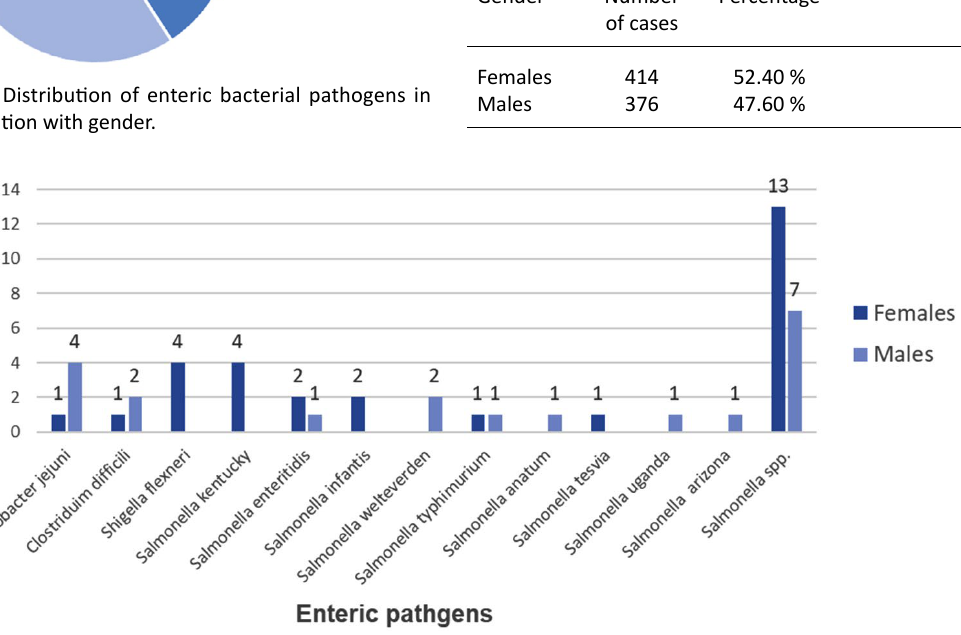
Fig. 3. Distribution of enteric bacterial pathogens in females &